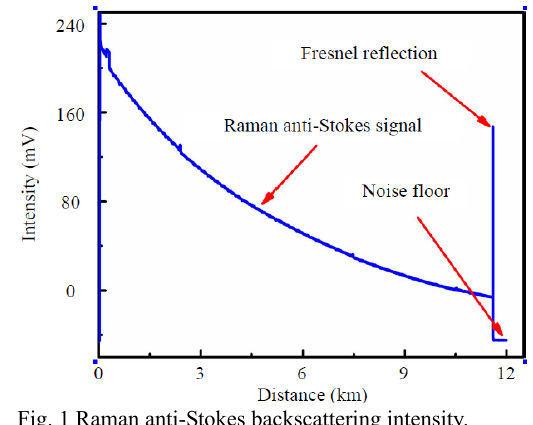
Fig. 1 Raman anti-Stokes backscattering intensity. Figure 1